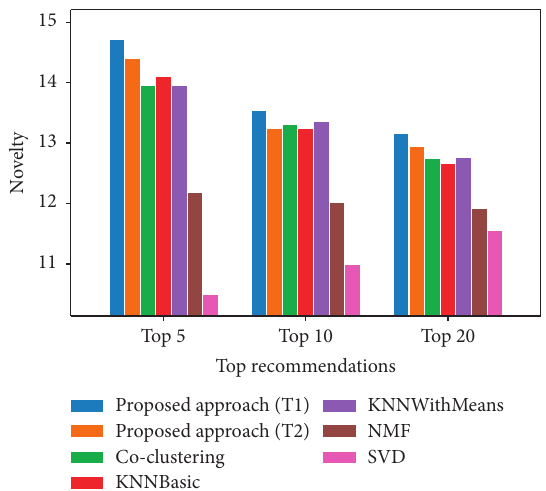
Figure 6: Novelty at (k) where k � 5, 10, and 20.